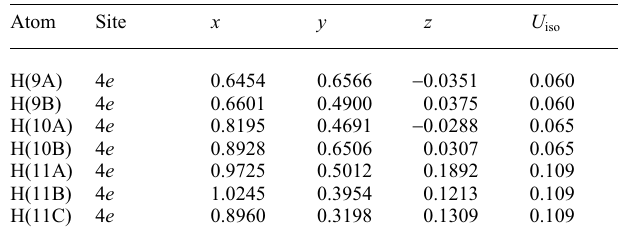
Table 2. Atomic coordinates and displacement parameters (in Å 2 )